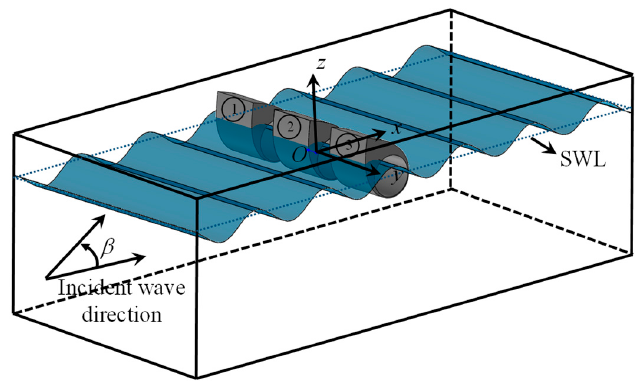
Figure 1. Schematic model of the isolated WEC rotor.